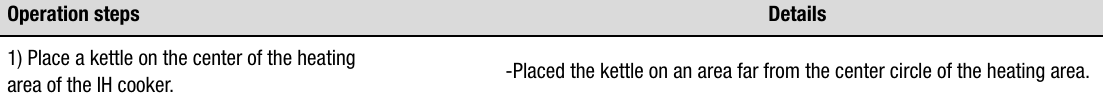
Table 2. Details of operation errors.